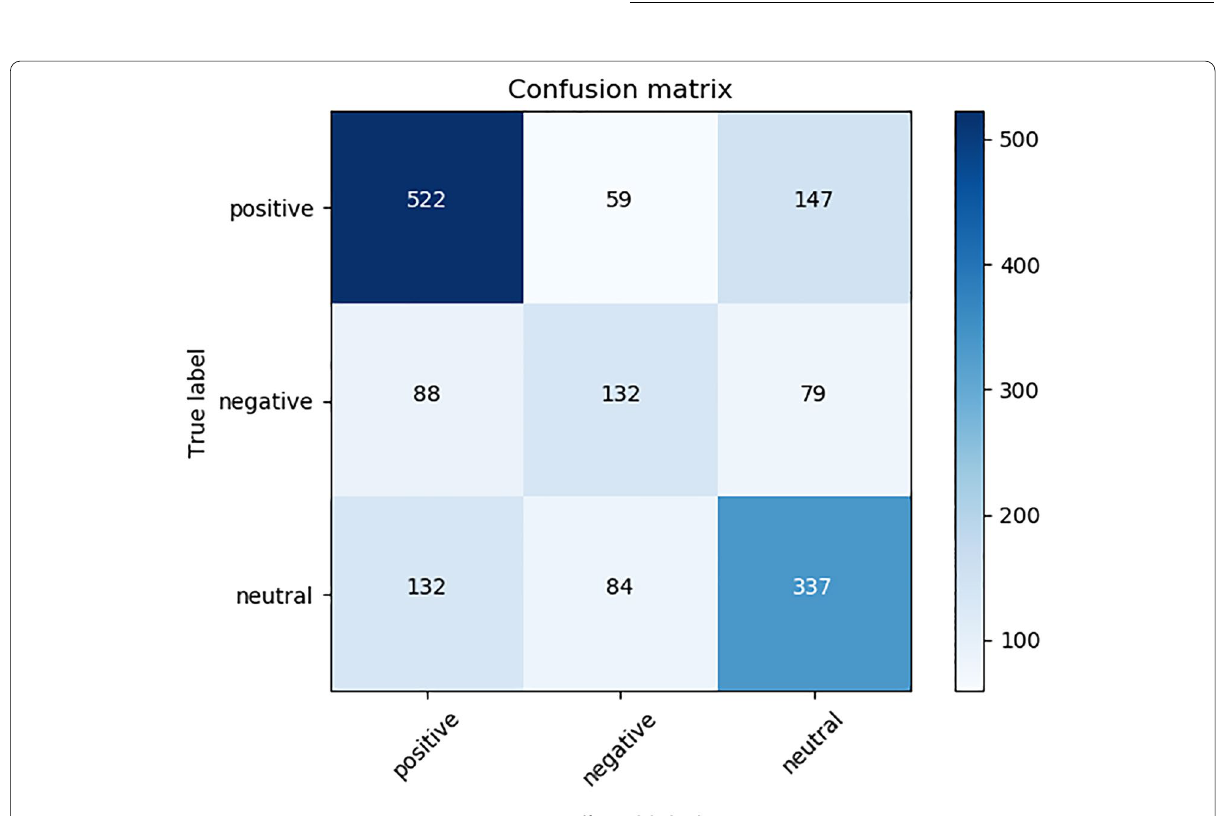
Fig. 9 The confusion matrix of the ensemble model on the concussion dataset